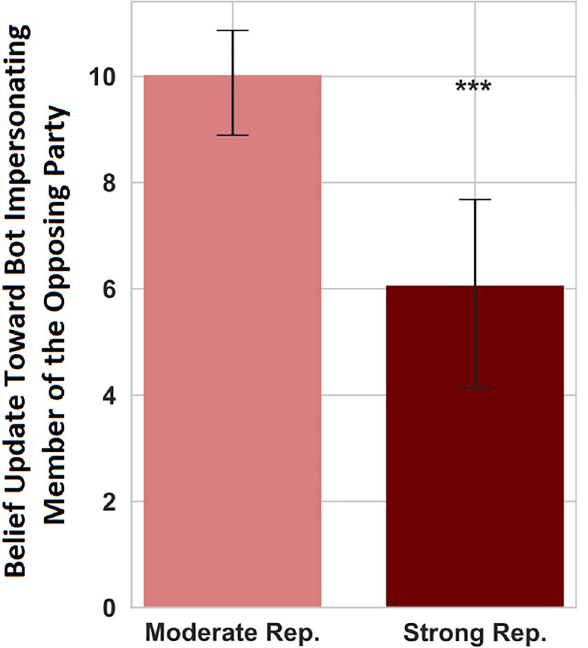
Figure 3. The extent that Republicans updated their beliefs toward the opinion of the Democrat bot during the online task across experimental conditions, split by the strength of partisanship. The data are collapsed across conditions. Vertical axis describes the post-stratified average belief update (in percentage points), where strata are defined by gender, political knowledge, the accuracy of initial guess, and awareness of bot’s membership in the opposing party. Larger values indicate that the participant updated their beliefs to become closer to the bot’s opinions, demonstrating greater receptivity to social influence from the other party. Strong Republicans (Rep.) are defined as those who are in the top 10th percentile of partisan identification measured by feeling thermometers. Moderate Republicans (Rep.) are those in all other percentiles. These “moderate republicans” provide a baseline of comparison. Error bars display 95% confidence intervals. ***p < 0.001. See SI for description of our post-stratification